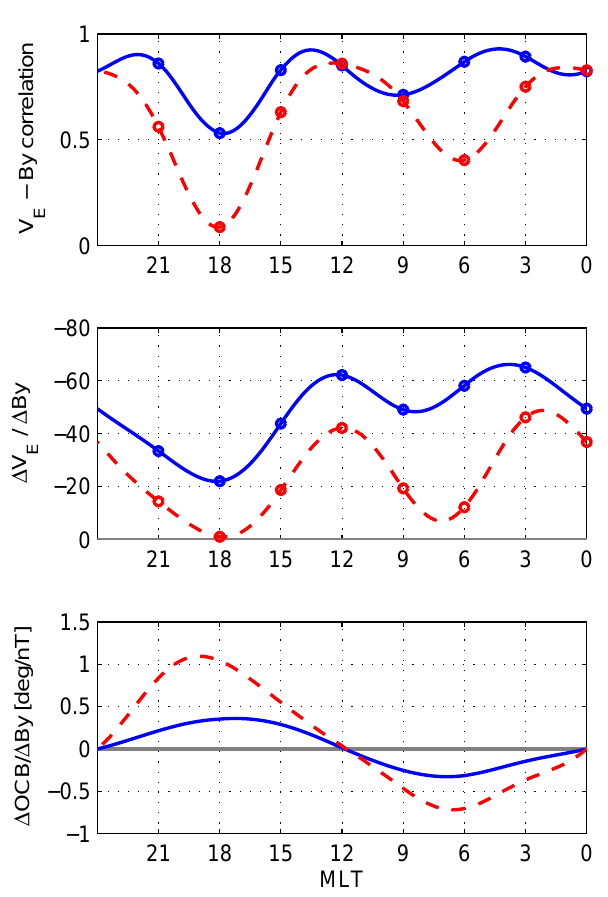
Fig. 4. The values of correlation C corr (upper panel) and regression K (middle panel) coefficients for the V E and IMF B y relationship for different MLT, separately for IMF B z < 0 and B z > 0. The bot- tom panel shows the shift of polar cap boundary caused by IMF B y changes for different MLT. Red and blue curve corresponds to B z > 0 and B z < 0, respectively.